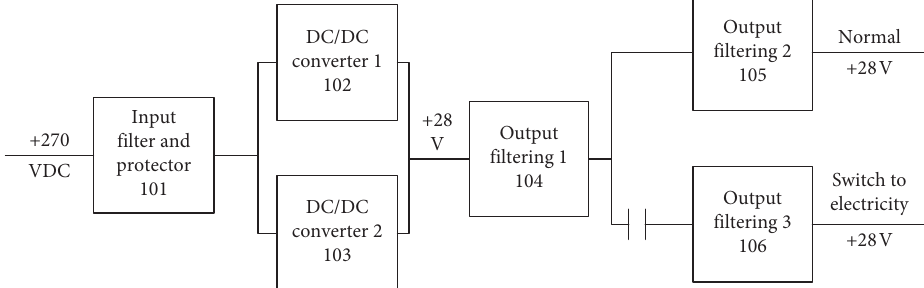
Figure 8: Functional block diagram of power source module.